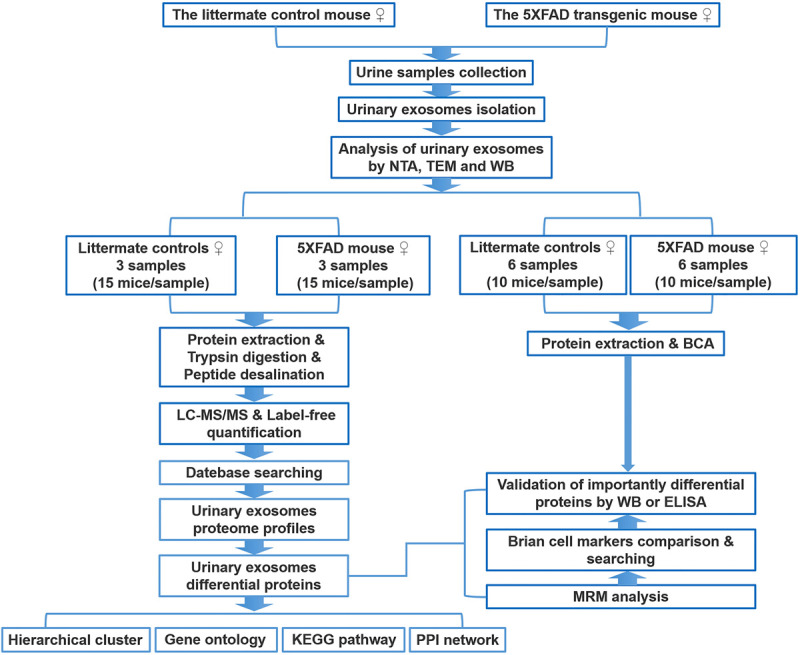
Workflow of isolation, characterization, and proteomics of urinary exosomes in 5XFAD transgenic mouse model of AD and littermate control. The proteins were analyzed using liquid chromatography coupled with tandem mass spectrometry (LC-MS/MS), MRM, WB, and ELISA. Differential proteins were analyzed by bioinformatics analysis. See text for details.